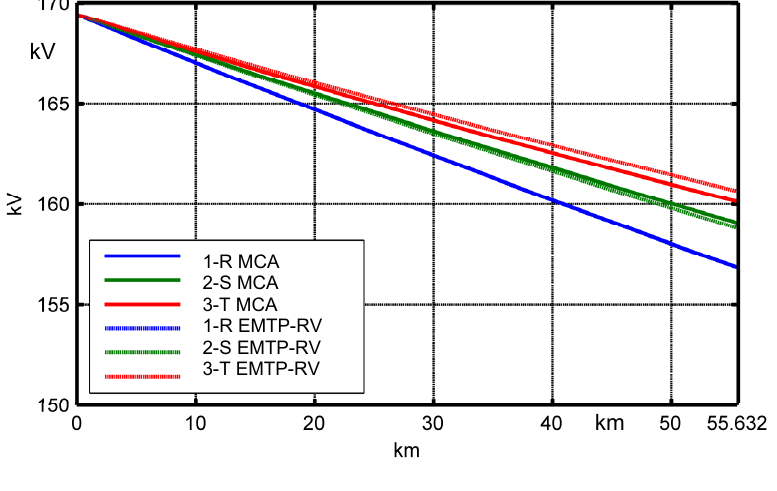
Figure 12. Voltage magnitude comparison between MCA and EMTP-RV along the